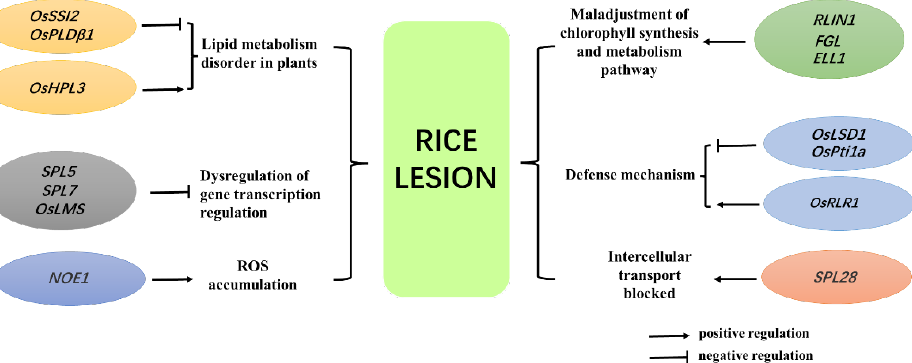
Figure 2. Part of the regulation pathway of lesion mimic genes in rice. (The regulatory pathways involved in rice lesion mimic genes mainly include lipid metabolism and chlorophyll synthesis metabolism in plants, transcription pathways of plant cell death, defense pathways of plants, intercellular transport pathways, and ROS signal transduction pathways.).